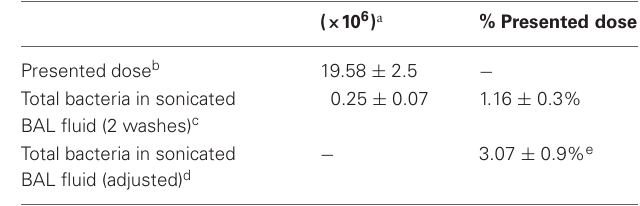
Table 3 | Lung dose (deposited dose) determined by analysis of BAL